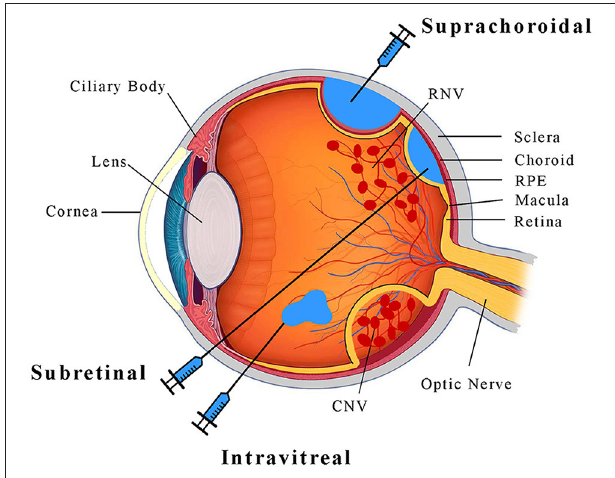
FIGURE 1 | A schematic diagram illustrrating the anatomy of the eye and ocular injection methods.